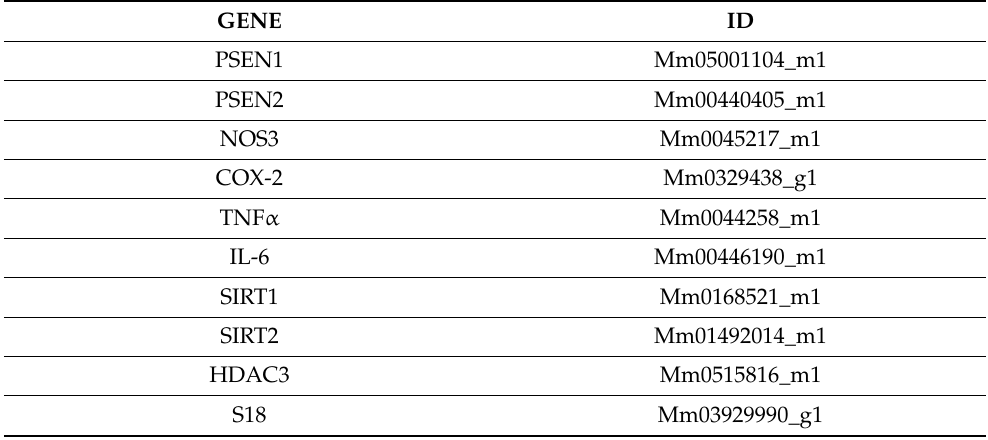
Table 4. List of TaqMan